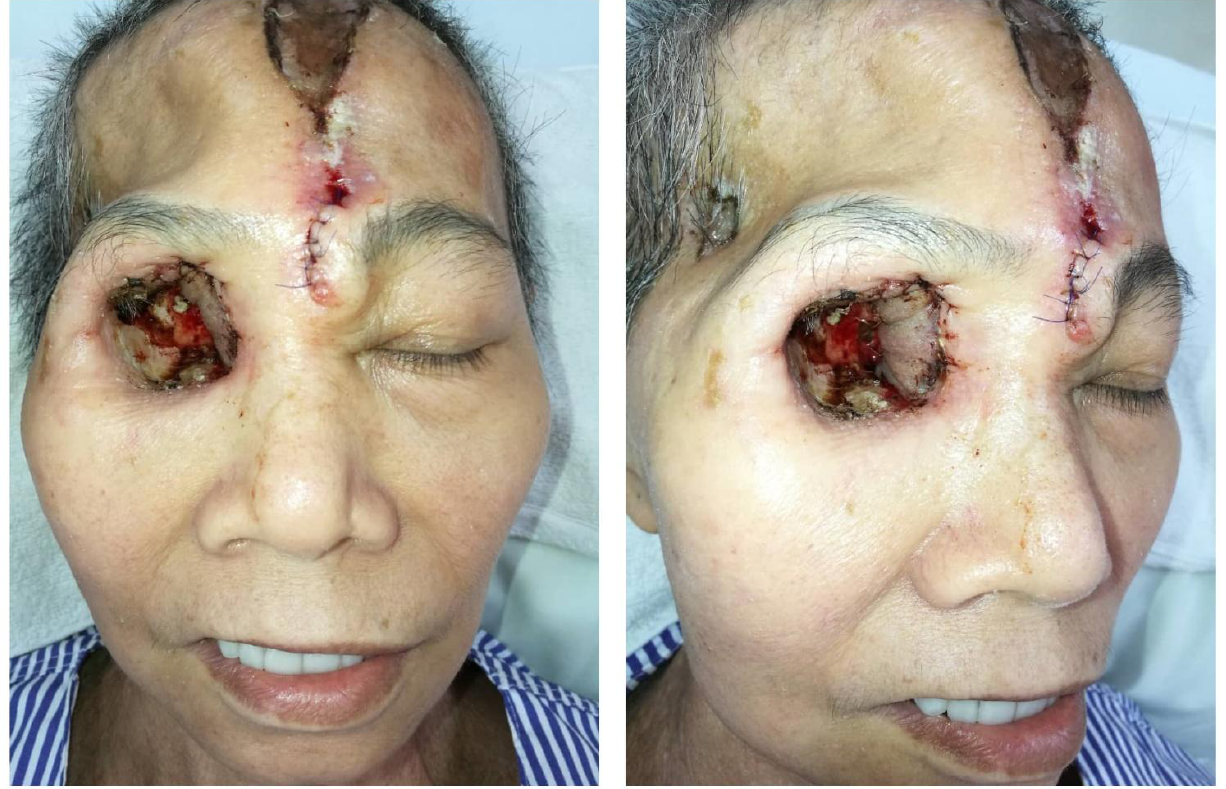
Figure 3: Final result after 3 weeks of flap delay and flap division &